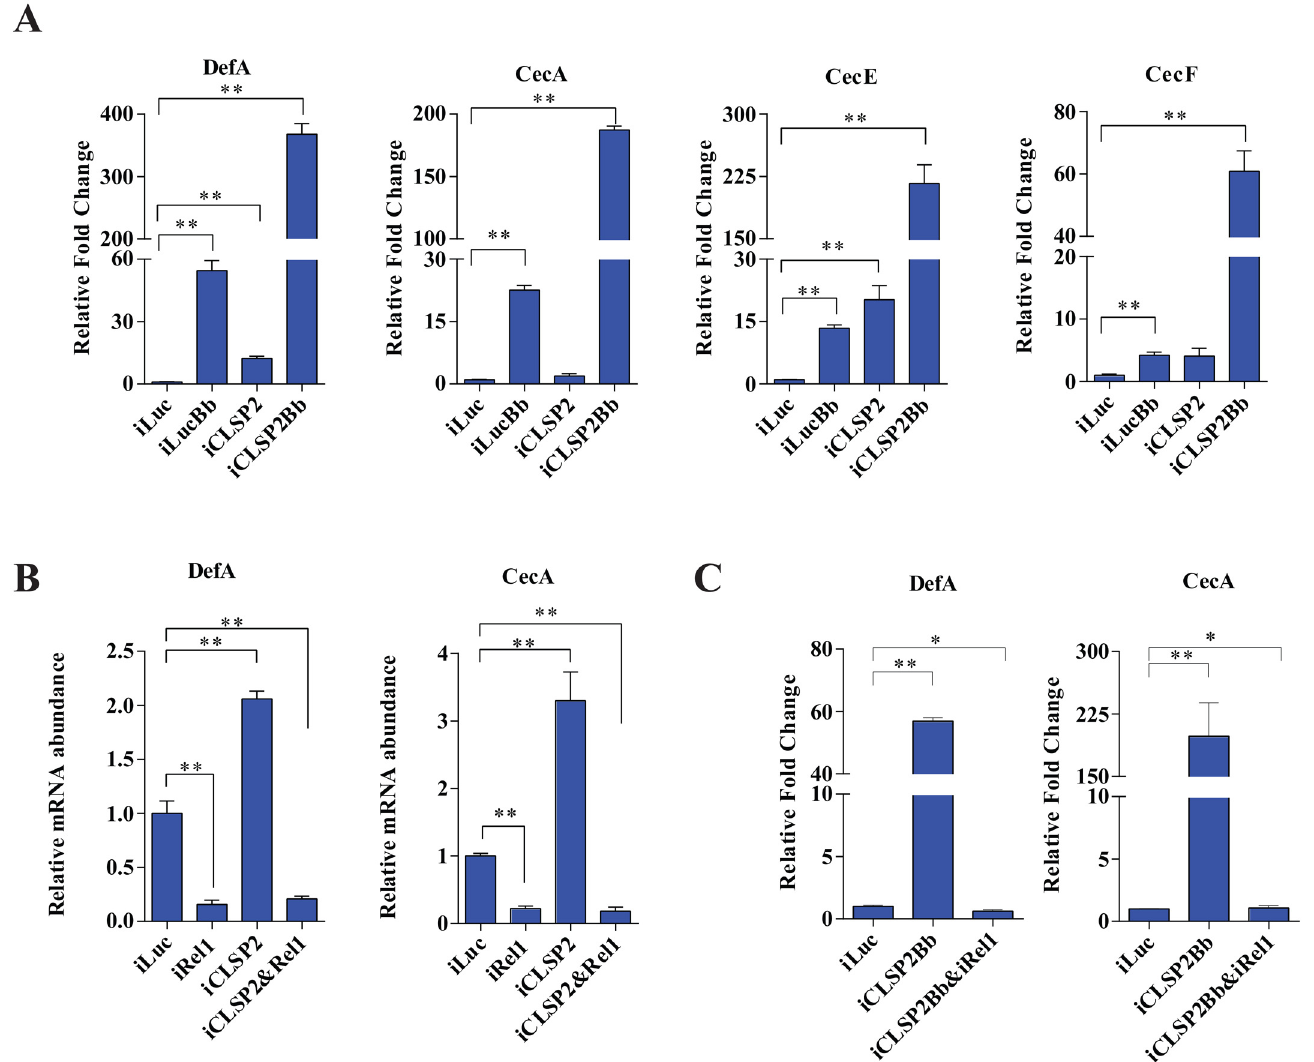
Fig 3. The effect of CLSP2 on the expression of AMPs. A) The mRNA levels of DefA , CecA , CecE , and CecF were determined using real-time RT-PCR. Data are presented as mean ± SEM. * , p < 0.05; ** , p < 0.01. The experiments were repeated four times. Data were normalized to the expression level of iLuc. iLucBb, iLuc-depleted mosquitoes infected with B . bassiana ; iCLSP2Bb, CLSP2 RNAi depleted mosquitoes infected with B . bassiana ; iCLSP2, CLSP2 RNAi depleted mosquitoes; iLuc, luciferase RNAi-treated control mosquitoes. B-C) The effect of double-knockdown of CLSP2 and Rel1 on the expression of AMPs (B) and the response to fungal challenge (C). The mRNA levels of DefA , CecA were determined using qRT-PCR. Data are presented as mean ± SEM. ** , p < 0.01. Data were normalized to the expression level of iLuc. iCLSP2, mosquitoes treated with CLSP2 dsRNA; iRel1, mosquitoes treated with Rel1 dsRNA; iCLSP2&Rel1, mosquitoes treated with CLSP2 and Rel1 dsRNA; iLuc, luciferase RNAi-treated control mosquitoes. iCLSP2Bb&Rel1 and iCLSP2Bb, CLSP2 and Rel1 RNAi depleted mosquitoes infected with B . bassiana